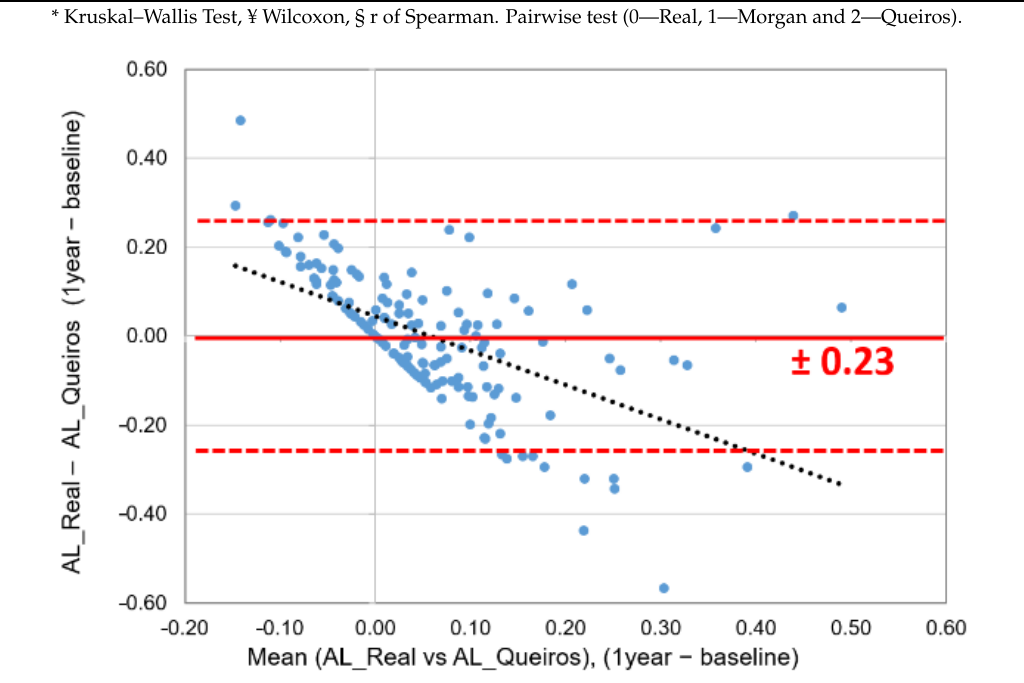
Table 3. Diagnostic efficacy of axial length calculation. The mean area under the curve and its range is